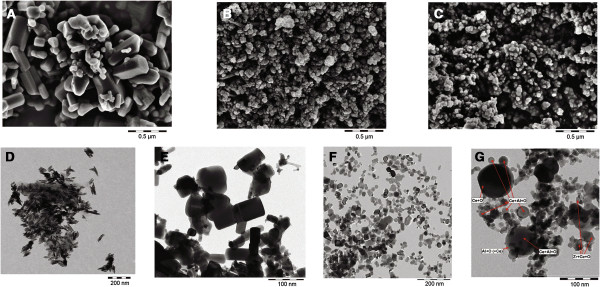
Scanning and transmission electron microscopy (SEM and TEM) images of the powder test materials. A: micron-scale ZnO, B: BaSO4, C: nano-ZrO2, D: coated nano-TiO2, E: coated nano-ZnO, F: nano-CeO2, G: Al-doped nano-CeO2. A-C: SEM images. D-G: TEM images. Note slightly different sets of scales in order to point to the individual characteristics of the respective test materials.